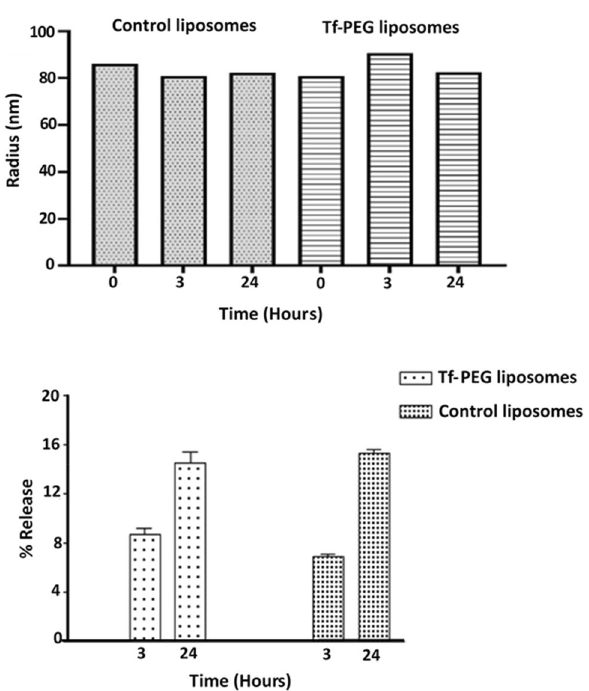
Figure 6. Average radius (top) and percentage calcein release (bottom) for the control and Tf-PEG liposomes following the incubation at 37 °C in fetal bovine serum medium for 3 h and 24 h. Results are the average of three liposome